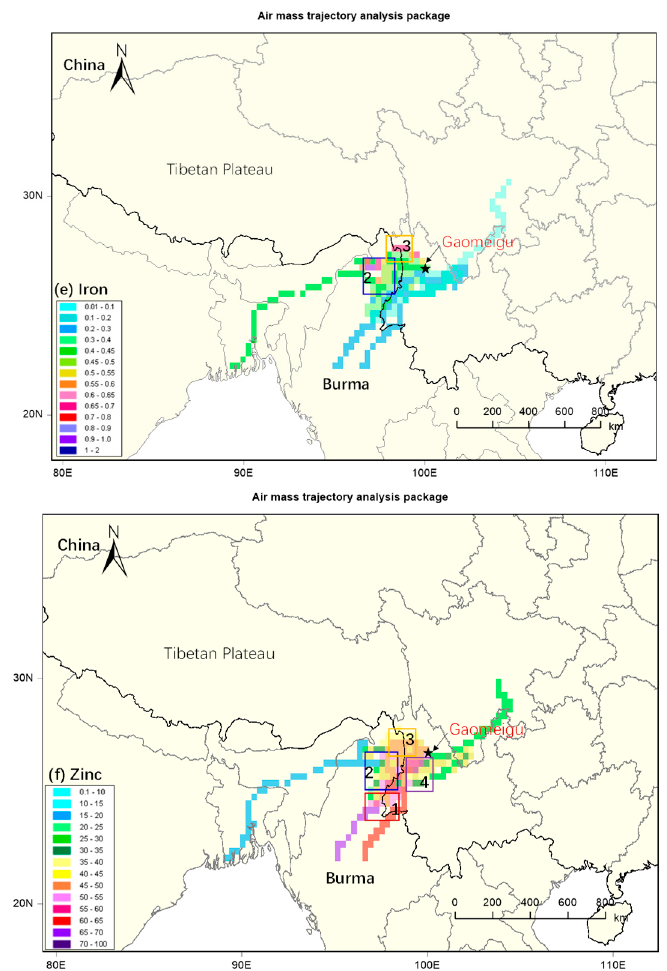
Figure 4. Maps of the concentration-weighted trajectories (CWT) for PM 2.5 ( a ) and different chemical species (i.e., EC ( b ), sulfate ( c ), nitrate ( d ), iron ( e ), and zinc ( f )) at arrival heights of 1000 m above ground level during the campaign. The CWT analysis was conducted by TrajStat software developed by Wang, Zhang and Draxler [46]. Grid cells with light blueish and greenish hues indicate the weak or insignificant sources in those areas, and the yellowish and orangish shades represent the probability of moderate sources, while pink, red, violet, and purple signify the presence of relatively strong particulate sources to PM at the receptor site.